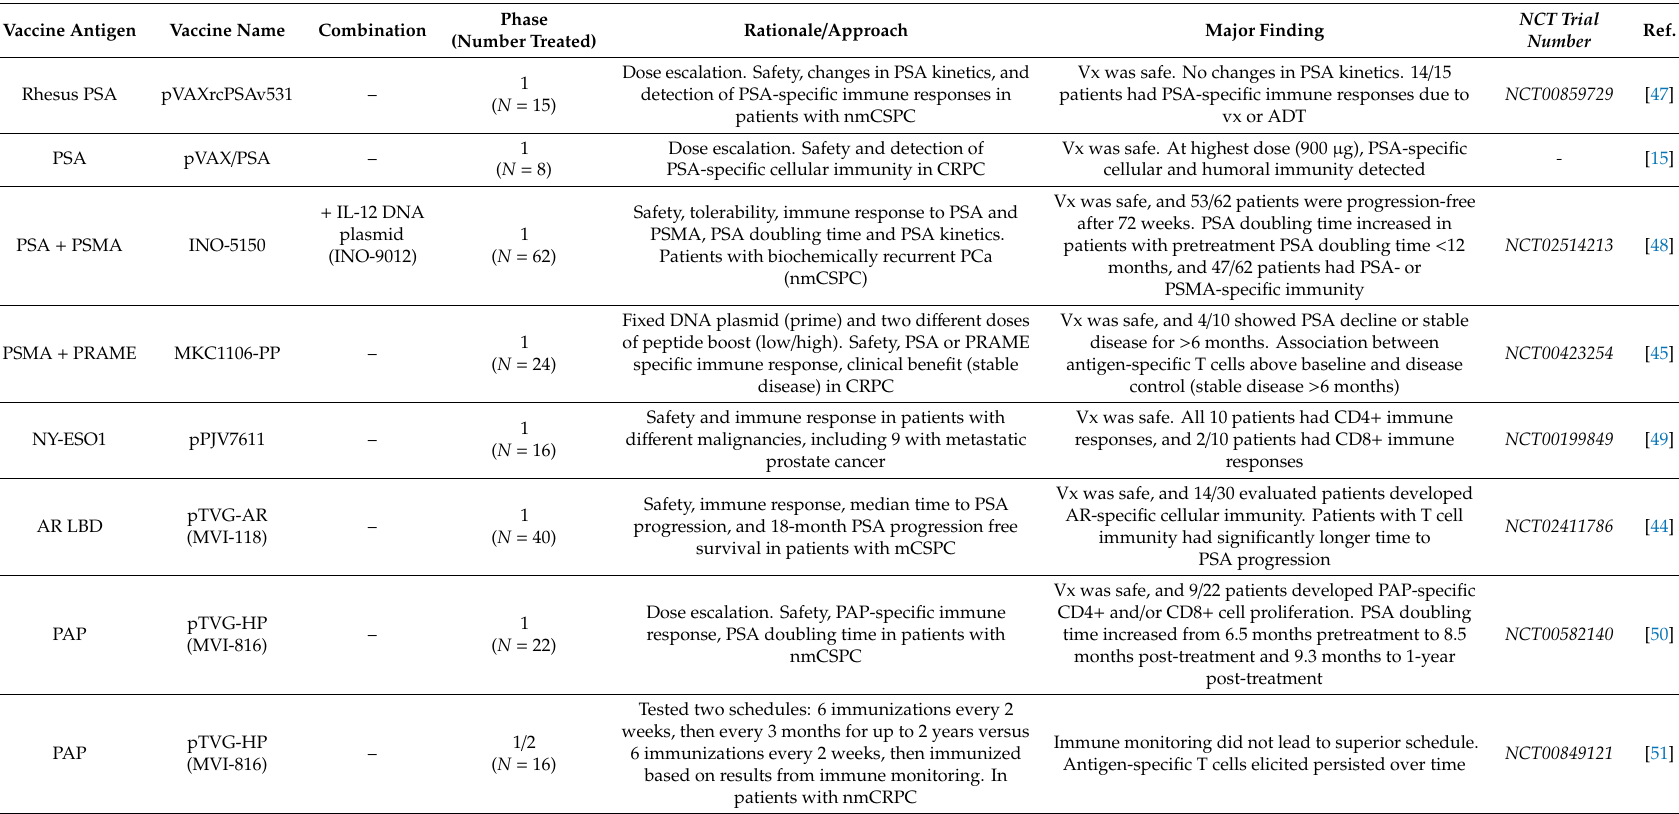
Table 1. Clinical trials with DNA vaccines (both as monotherapy and in combination) in prostate cancer to